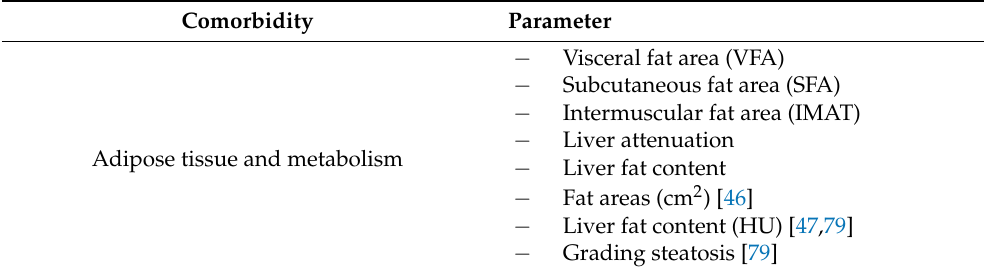
Table 1. Biomarkers of comorbidities for comprehensive quantitative and qualitative analysis of chest CT. Comorbidity Parameter − Visceral fat area (VFA) − Subcutaneous fat area (SFA) − Intermuscular fat area (IMAT) − Liver attenuation Adipose tissue and metabolism − Liver fat content − Fat areas (cm 2 ) [46] − Liver fat content (HU) [47,79] − Grading steatosis